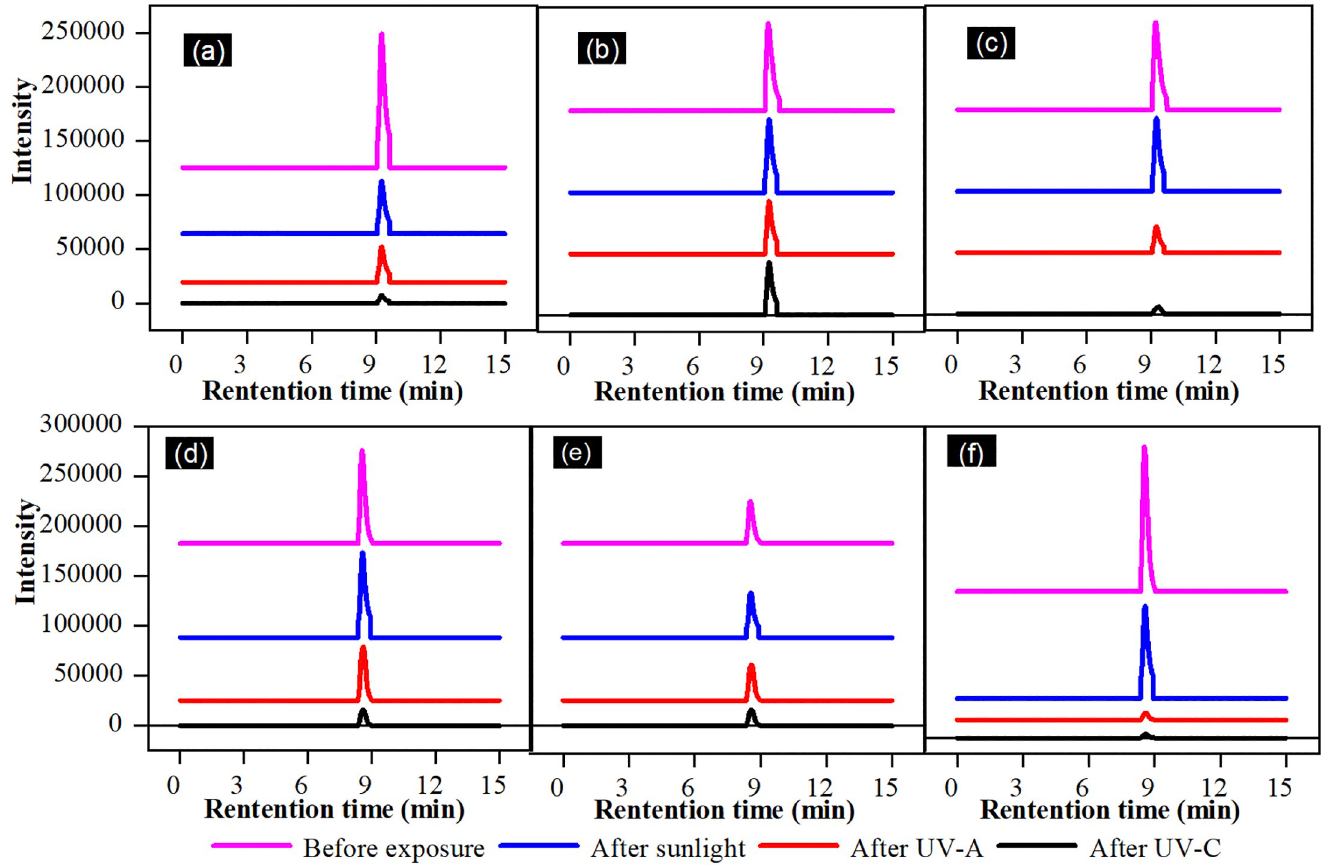
Fig 3. Effect of light and photosensitizers on DM and λ -CHT pesticides degradation a) DM + Light; b) DM + Light + Mint; c) DM + Light + Riboflavin; d) λ -CHT + Light; e) λ -CHT + Light + Mint; f) λ -CHT + Light + Riboflavin.